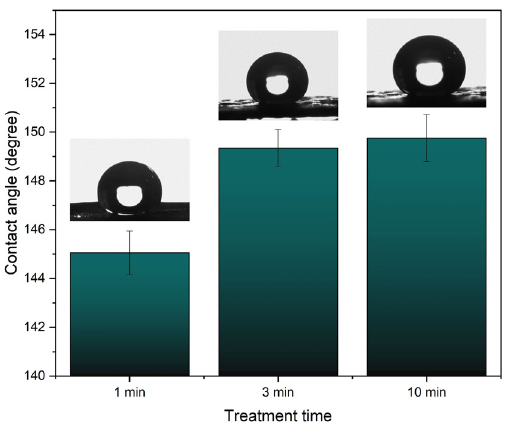
Figure 9. Water contact angle values for plasma treatment times of 1, 3 and 10 minutes. The insert shows the photographs of the water drops on the surface of the plasma-treated